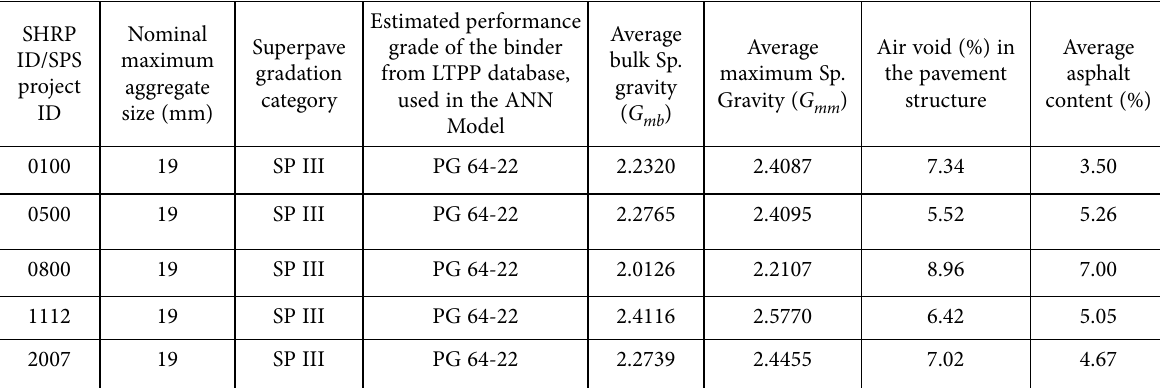
Table 2. Information on the HMA materials at the selected LTPP sections